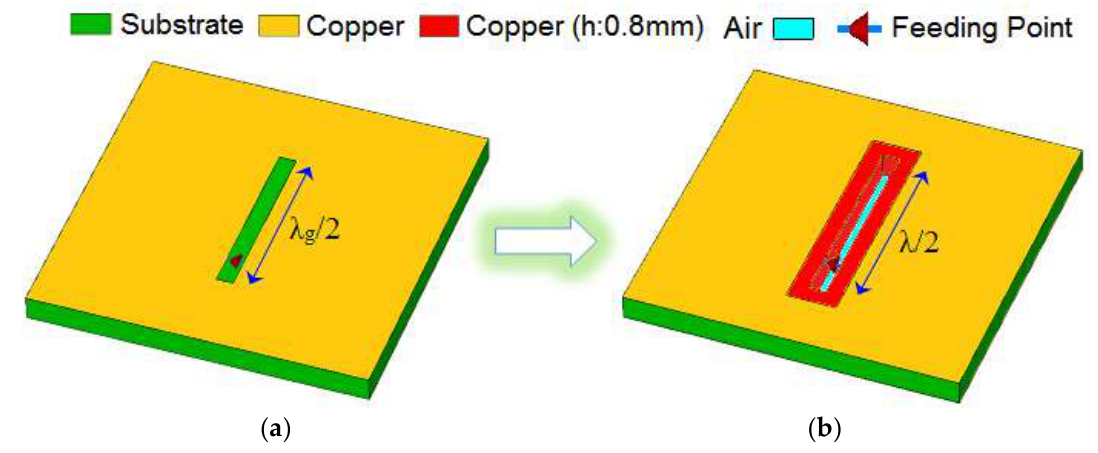
Figure 4. ( a ) Conventional 𝜆 /2 slot resonator and ( b ) the configuration of the proposed metal- ring/air-filled slot.